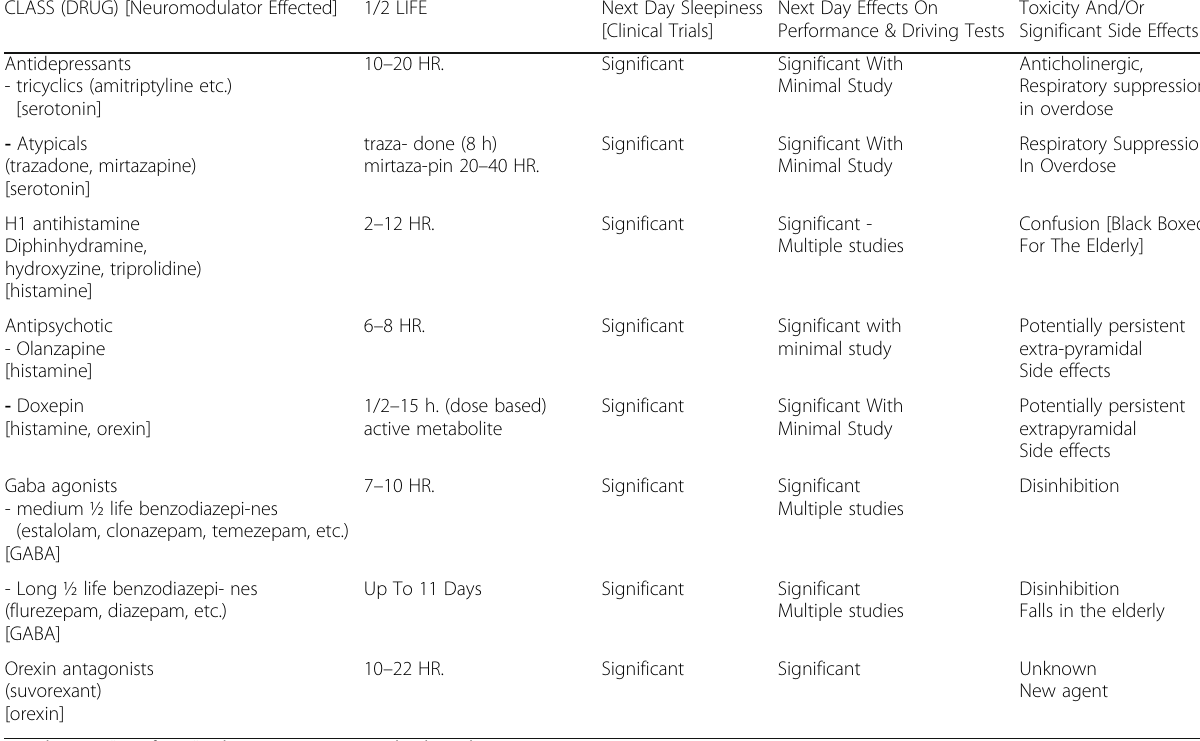
Table 4 Sedatives - Agents Used To Induce Sleep And Sedation With Significant Next Day Sleepiness After Used Based On Pharmacodynamics, Clinical Trials, And/Or Performance Testing CLASS (DRUG) [Neuromodulator Effected] 1/2 LIFE Next Day Sleepiness [Clinical